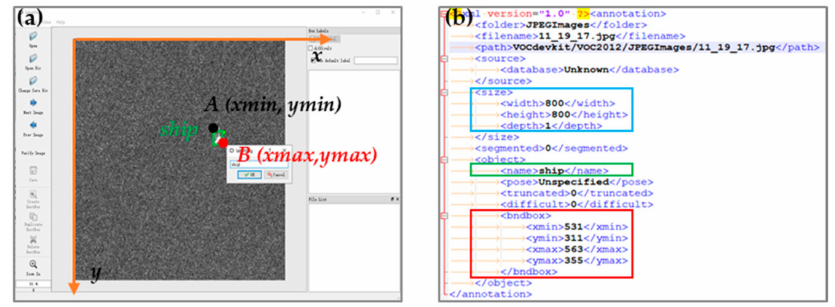
Figure 6. Expert annotation. ( a ) LabelImg annotation tool; ( b ) xml label